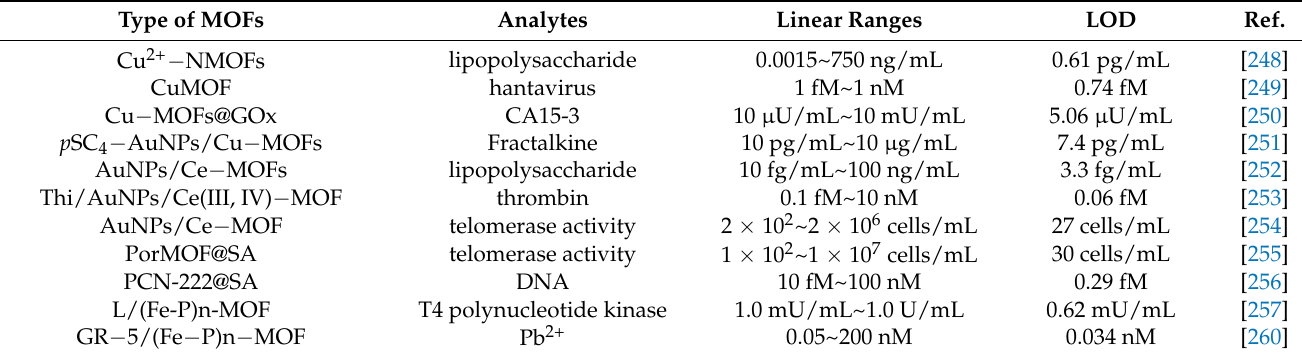
Table 8. Detection performances of different electrochemical sensors by using MOFs as